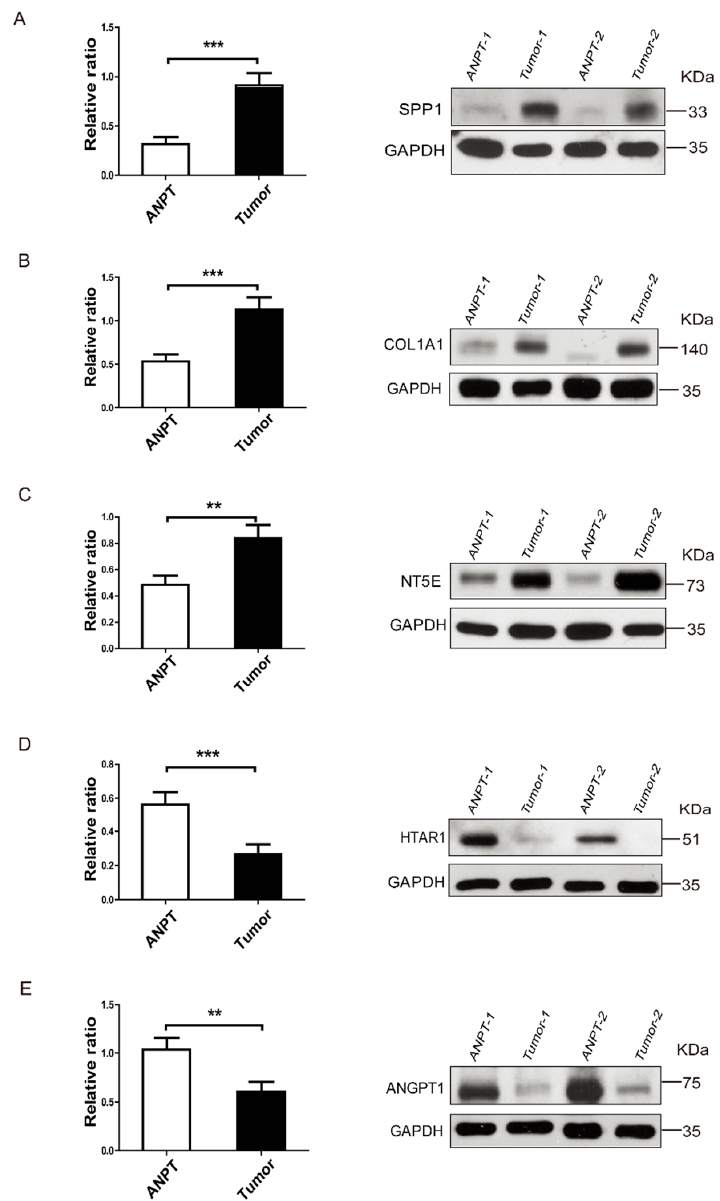
Figure 4. Gene expression profile of ACTH-secreting pituitary adenomas using western blot assay. SPP1 ( A ), COL1A1 ( B ), NT5E ( C ), HTRA1 ( D ) and ANGPT1 ( E ) protein levels in ANPT and ACTH-secreting pituitary adenomas are assessed using western blots in 29 female paired pituitary tissues. Bar graph shows the SPP1/GAPDH relative ratio, COL1A1/GAPDH relative ratio, NT5E/GAPDH relative ratio, HTRA1/GAPDH relative ratio and ANGPT1/GAPDH relative ratio (ANPT n = 29, tumors n = 29). The data are representative of three technical repeats with the mean ± SEM (two-tailed Student’s t -test, ** p < 0.01, *** p < 0.001. ANPT versus tumors). SPP1 , COL1A1 , NT5E , HTRA1 and ANGPT1 genes all encoded five secreted proteins according